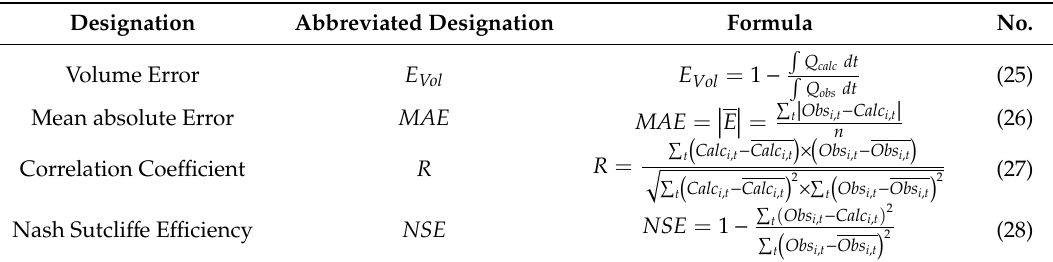
Figure 6. Average leaf area index per month derived from satellite data for different land use classes (based on one cloudless satellite image per month from November 2013 till October 2015). Table 2. Error measures and performance